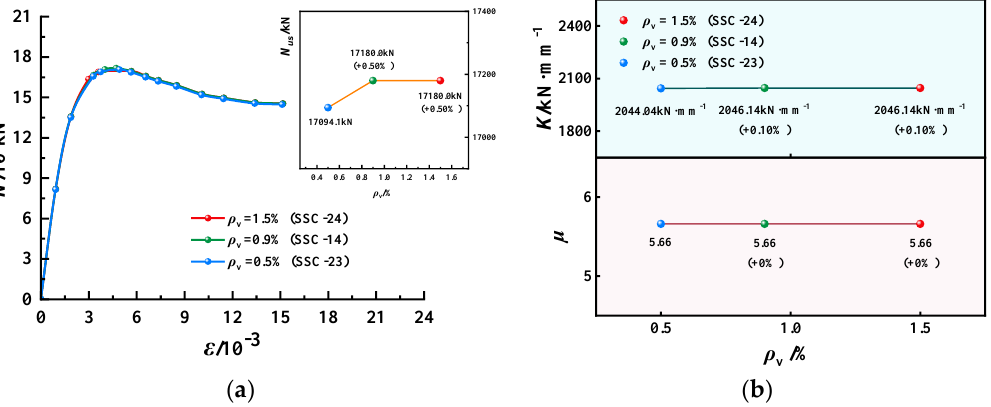
Figure 14. N - ε curves, K and µ of EGCSSCs with different ρ v : ( a ) N - ε curves of specimens with cross-section height of 1000 mm. ( b ) K and µ of specimens with cross-section height of 1000 mm.